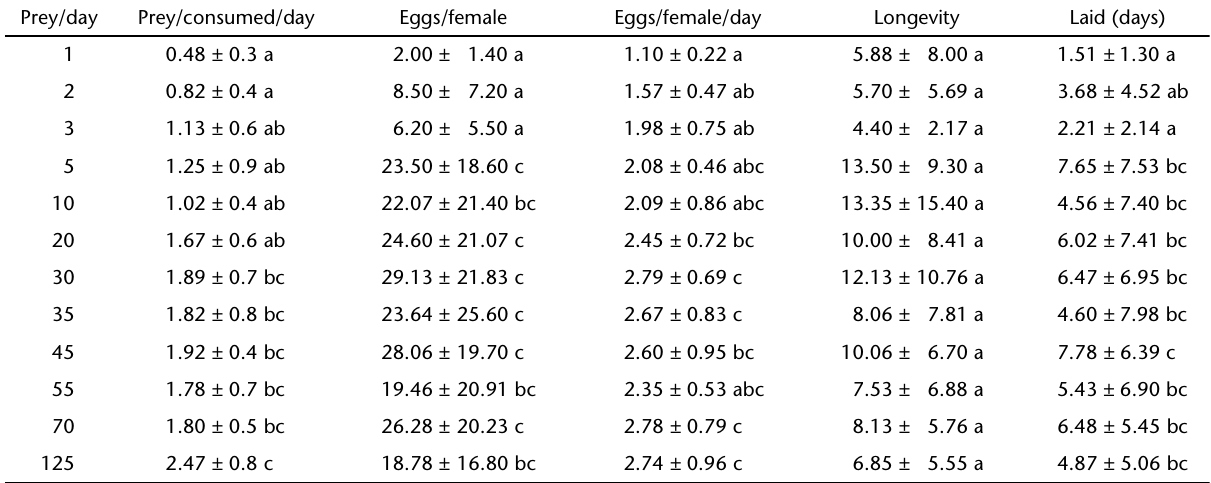
Table I. Functional response (mean ± SD) of P. macropilis in presence different density of T . urticae at 25 ± 1ºC, 12 hours photophase and 80 ± 5% relative humidity. In the same column, means followed by the same letter do not show difference at a significance level of 5%.